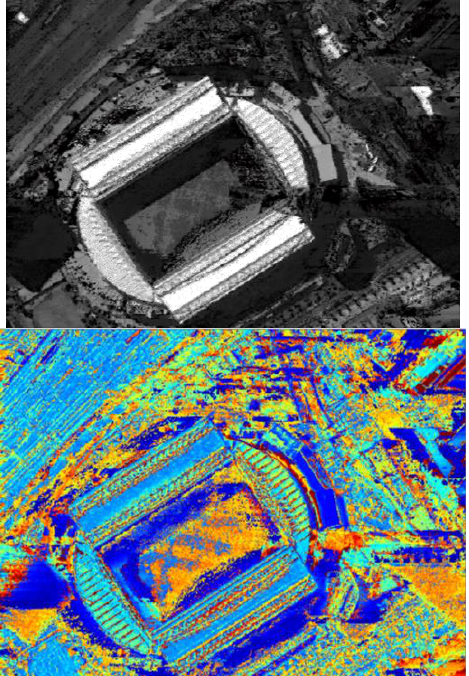
Figure 13. (Top) Lambertian map obtained from the BRDF inversion. (Bottom) Roughness maps obtained from the BRDF inversion. Most of the blue zone underline observed specular